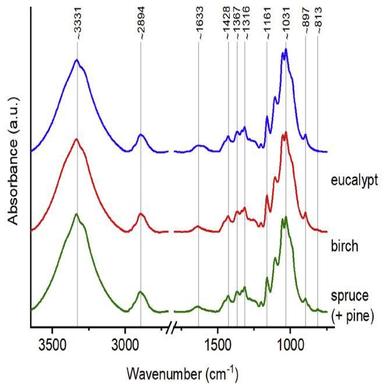
ATR and baseline corrected and vector normalized FT-IR spectra of CPD treated pulp fibers.